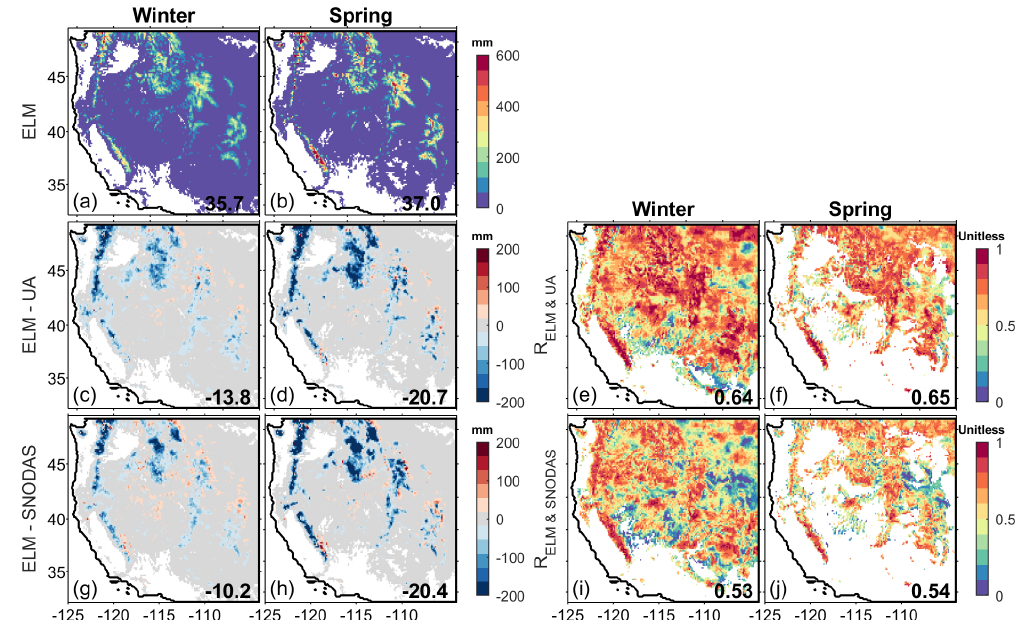
Figure 12. Spatial distributions of (a, b) snow water equivalent (SWE) in ELM, and (c, d, g, h) the SWE difference between ELM and two data assimilation products (i.e., UA and SNODAS) and (e, f, i, j) their temporal correlations ( R s ) for different seasons: (a, c, e, g, i) winter and (b, d, f, h, j) spring. In all panels, regions with no snow cover are masked with white color. The area-weighted average values are labeled in each panel.